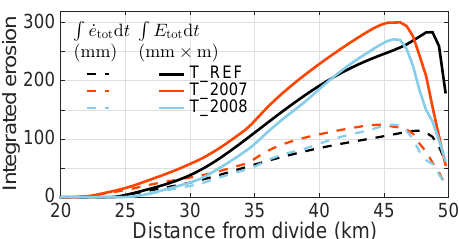
Figure 8. Comparison of time-integrated erosion per unit width ( R ˙ e tot d t ) and total erosion ( R E tot d t ) for different ice geometries. The first 20km of the profile are not shown because the bed is allu- viated and erosion rates are